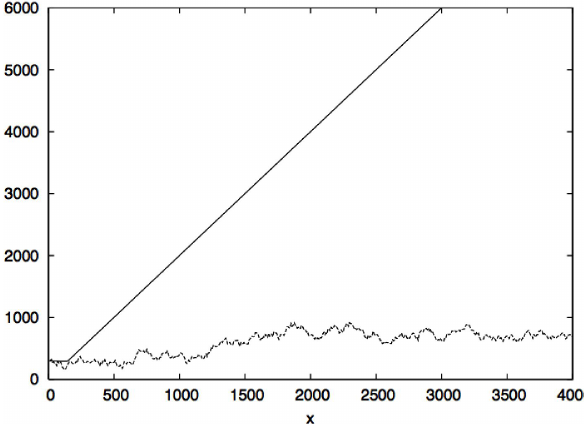
Fig. 12. The figure shows x(t) with (straight line) and without (dotted line) 8(x − vt) for a properly chosen value of σ . The initial particle position is 300 L and the initial perturbing potential is localized in x =